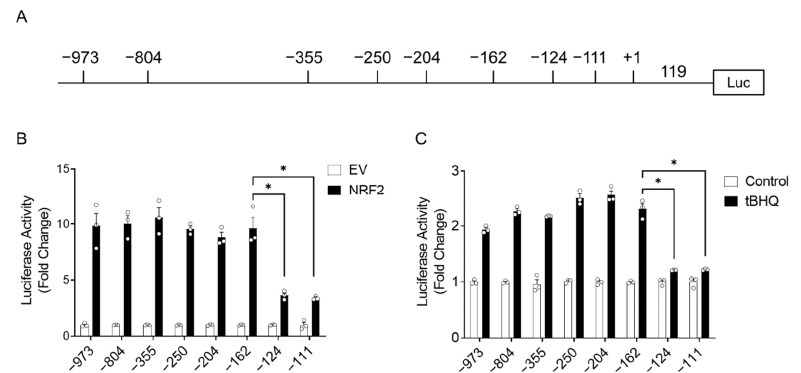
Figure 3. Effects of 5’ deletions in the CSE promoter sequence on NRF2-inducible activity. Schematic representation of the CSE promoter deletion constructs. Numbering is relative to transcription initiation site (+1) ( A ). iSAE cells were co-transfected with the CSE-PGL4-Luc deletion mutants and Renilla-Luc plasmid plus either the empty vector or the NRF2 expression vector and harvested 48 h later to measure luciferase activity. Luciferase activity was normalized to Renilla luciferase activity. Results are expressed as mean ± SEM of triplicate determination of a representative experiment repeated twice and expressed as fold change relative to empty vector. * p < 0.05 relative to − 973-PGL4-Luc ( B ). iSAE cells were co-transfected with the CSE-PGL4-Luc deletion mutants and Renilla-Luc plasmid for 24 h. Cells were left untreated or treated with tBHQ (25 µM) for 15 h before harvesting to measure luciferase activity. Luciferase activity was normalized to Renilla luciferase activity. Results are expressed as mean ± SEM of triplicate determination of a representative experiment repeated twice and expressed as fold change relative to control. * p < 0.05 relative to control cells ( C ). Each circle represents individual data.